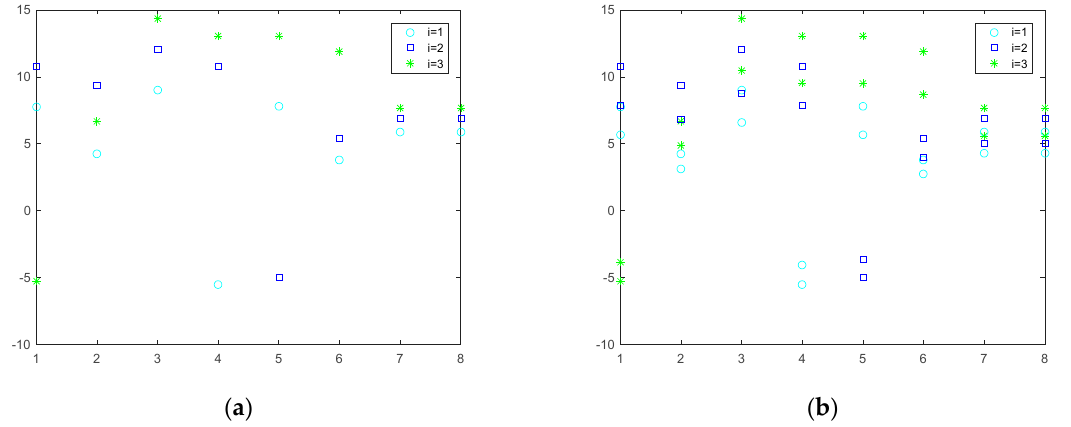
Figure 5. ( a ) Variation of 𝑢 (cid:3036)∗ (𝑡) for the feedback solution under infinite horizon at t = 10; ( b ) variation of